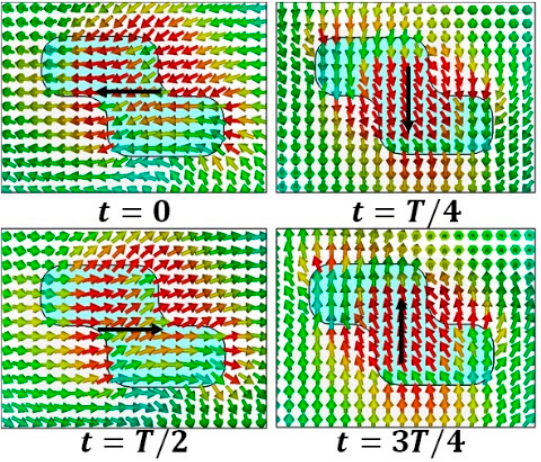
Figure 4. E-field distribution in z = 5.17 mm, z = 5.17 mm plane: ( a ) 9.64 and ( b ) 11.88 GHz.